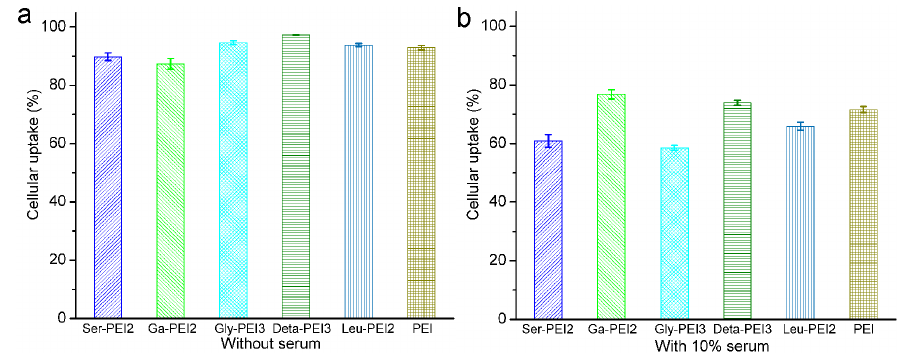
Figure 9. Cellular uptake of polyplexes at optimal weight ratio in U-2OS cells quantified by flow cytometry analysis. ( a ) Without serum; ( b ) In the presence of 10% serum. Data represent mean ± SD ( n = 3). ( n = 3).